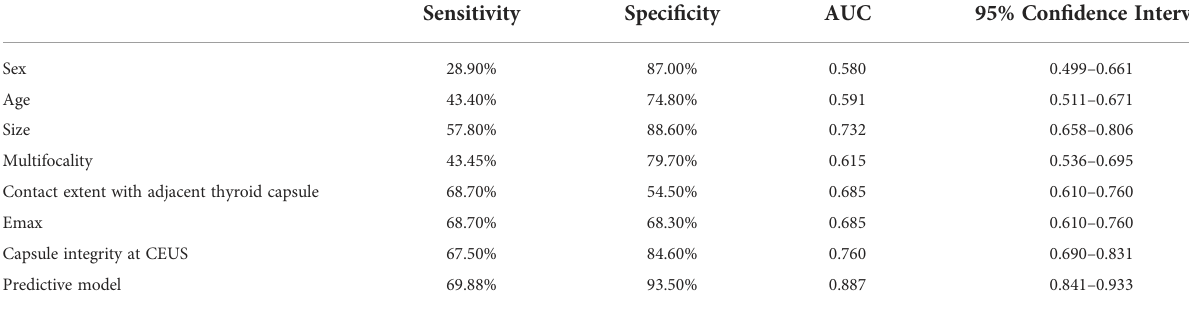
TABLE 4 The AUC of independent risk factors and predictive